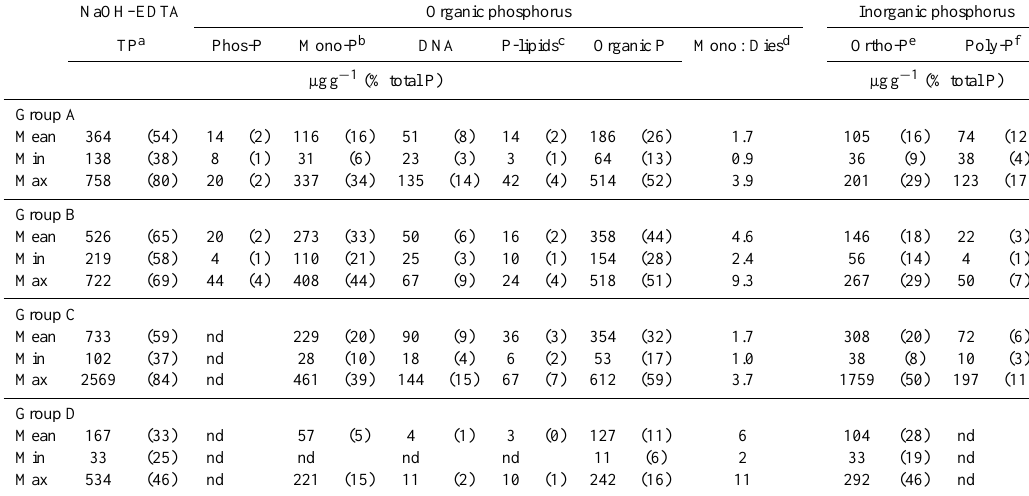
Table 2. Phosphorus composition of surface soils as determined by solution 31 P NMR spectroscopy. NaOH–EDTA Organic phosphorus Inorganic phosphorus TP a Phos-P Mono-P b DNA P-lipids c Organic P Mono : Dies d Ortho-P e Poly-P